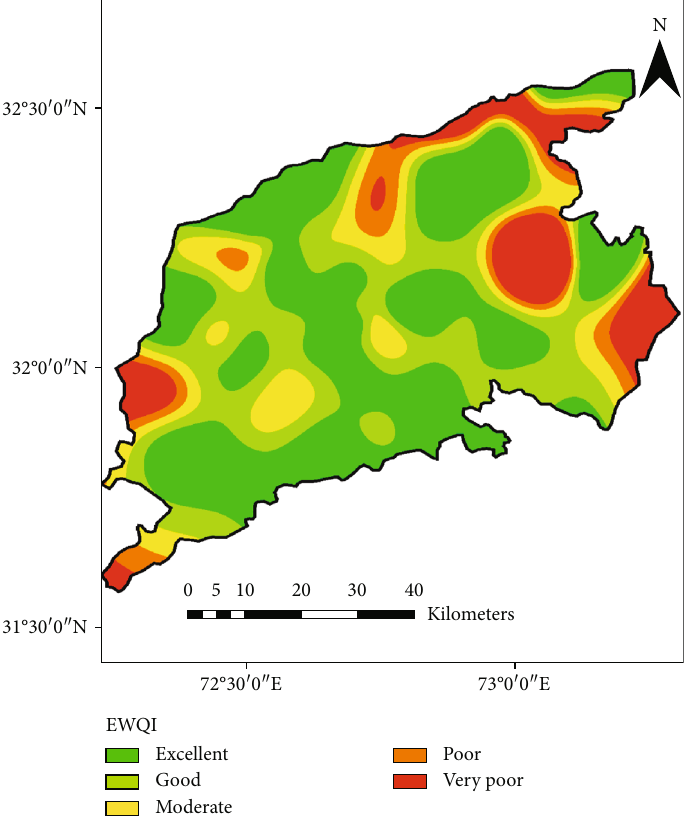
Figure 6: Entropy water quality index map. Table 4: Statistical summary of irrigation quality indices for the groundwater